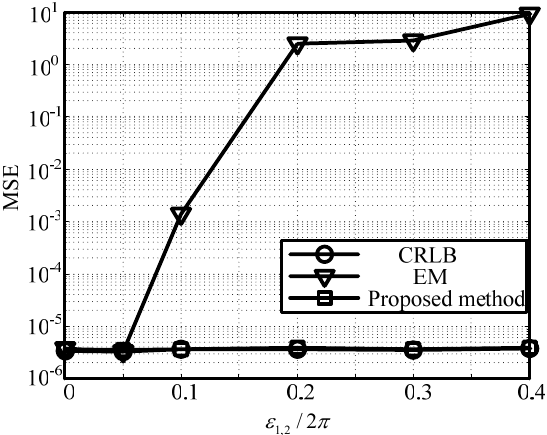
Fig. 5 Estimation performance of different